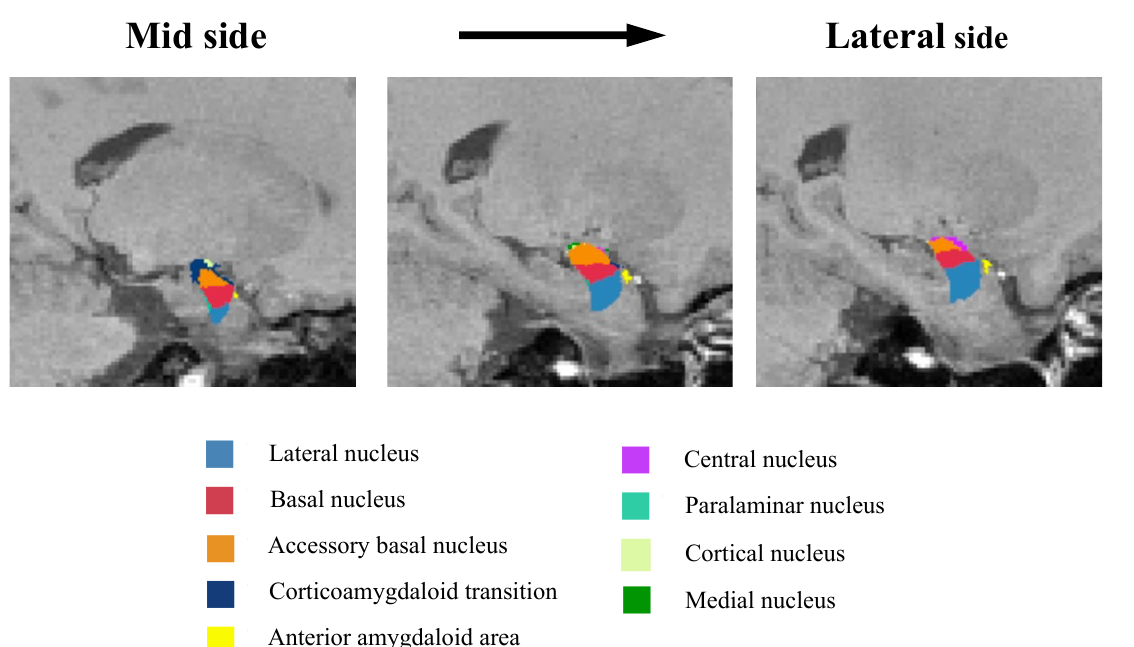
Table 2. Estimated total intracranial volume and plasma levels of metabolites.